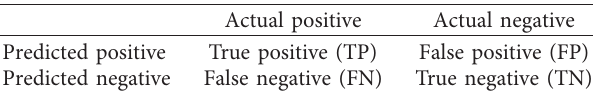
Figure 4: (a) Discharge temperature for cell with low lifetime, every 200 cycles; (b) discharge temperature for cell with high lifetime, every 200 cycles; (c) discharge voltage curves for cell with low lifetime, every 200 cycles; (d) discharge voltage curves for cell with high lifetime, every 200 cycles; (e) IC curve for cell with low lifetime, every 200 cycles; (f) IC curve for cell with high lifetime, every 200 cycles; (g) IR curve for cell with low lifetime; (h) IR curve for cell with high lifetime. Table 1: Metrics to evaluate classification